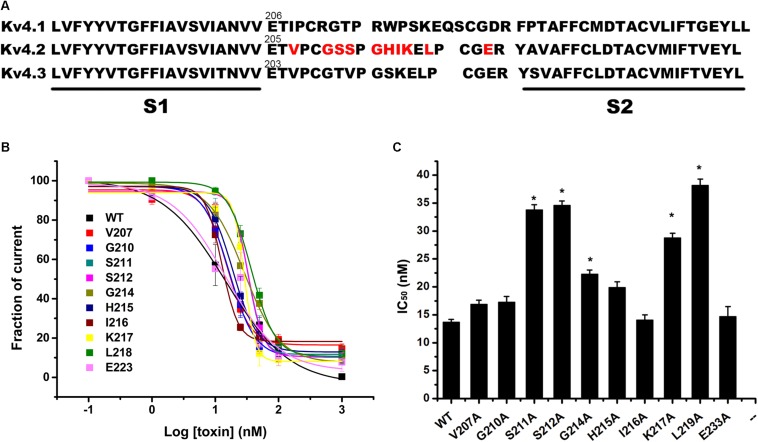
Inhibition effects of site mutants in the S1–S2 linker of Kv4.2 by JZTX-V. (A) Sequence alignment of S1–S2 regions of Kv4 subfamily a-subunits (Red were used in alanine-scanning mutagenesis). (B,C) IC50 values on Kv4.2 channel of JZTX-V and analogs. Data shown are the means ±SEM (N = 5). *P < 0.05 compared with WT group.